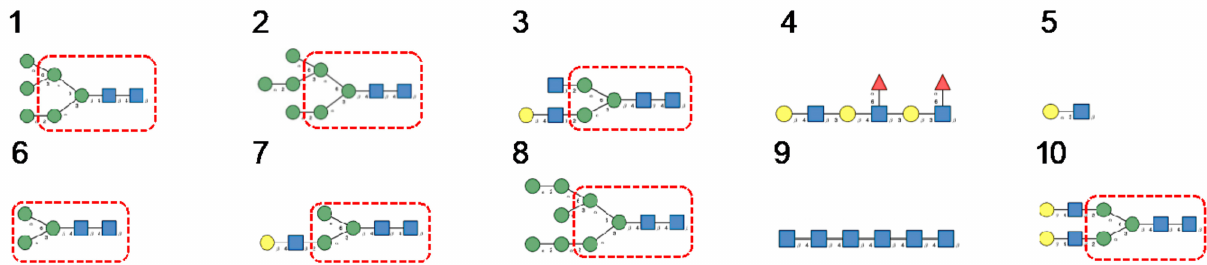
Figure 34. Glycans recognized by Nictaba in glycan array experiments, arranged from 1 to 10 in decreasing order of